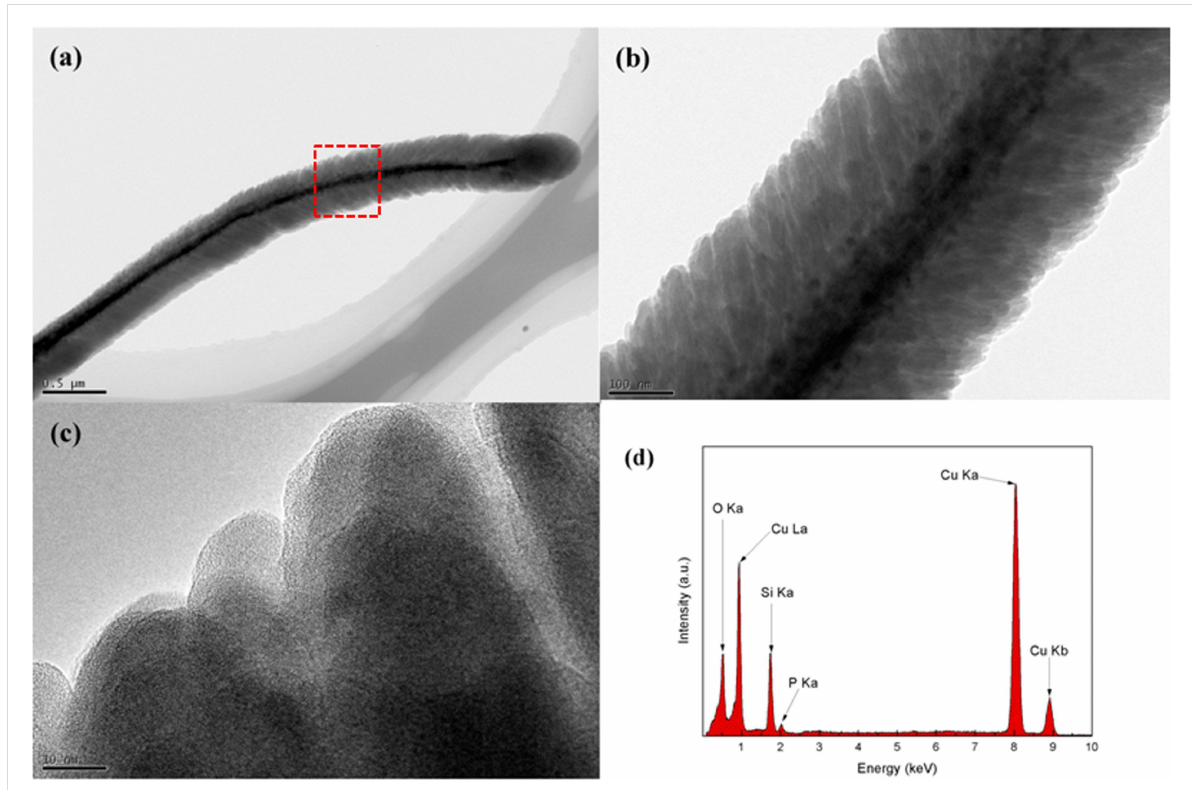
Figure 2: Transmission electron microscopy images for the Si nanorod at (a) low magnification (b) high magnification and (c) high-resolution TEM. (d) Energy dispersive spectra of the Si nanorod section as indicated by the red box in (a).